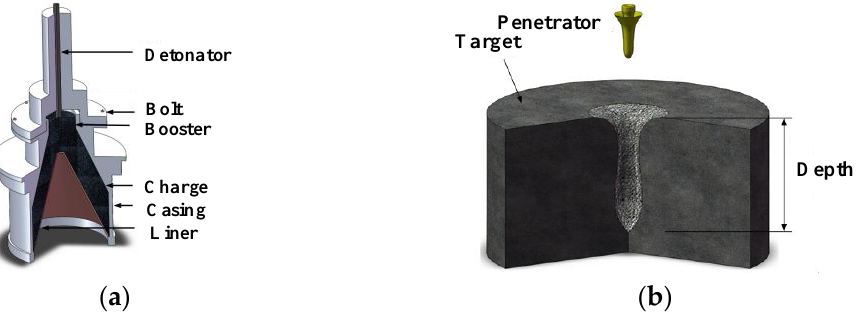
Figure 2. Experimental shaped-charge size (unit: mm): ( a ) Small; ( b ) Medium.